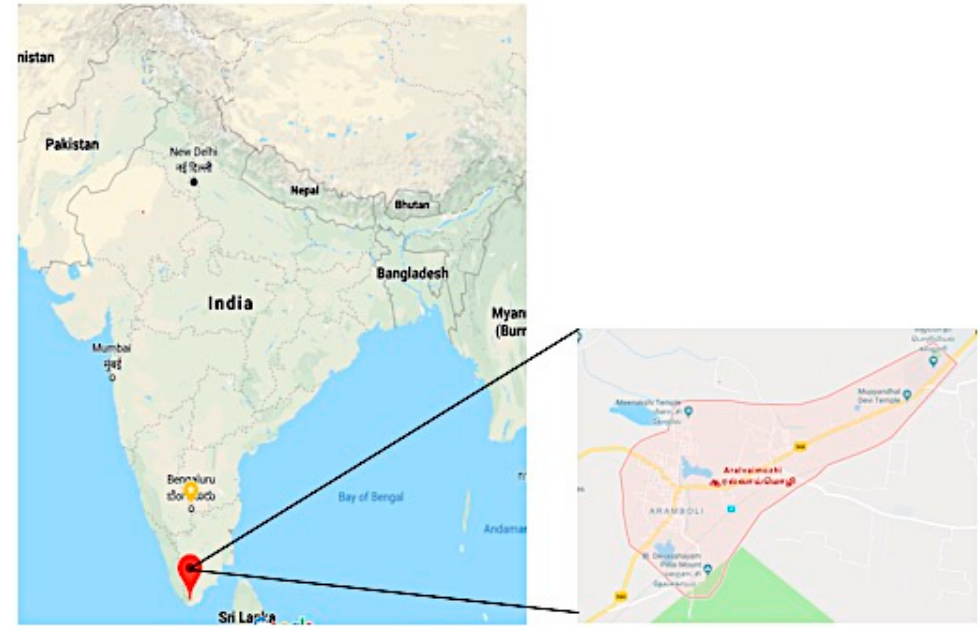
Figure 3. Location of the selected site, Aralvaimozhi, India.